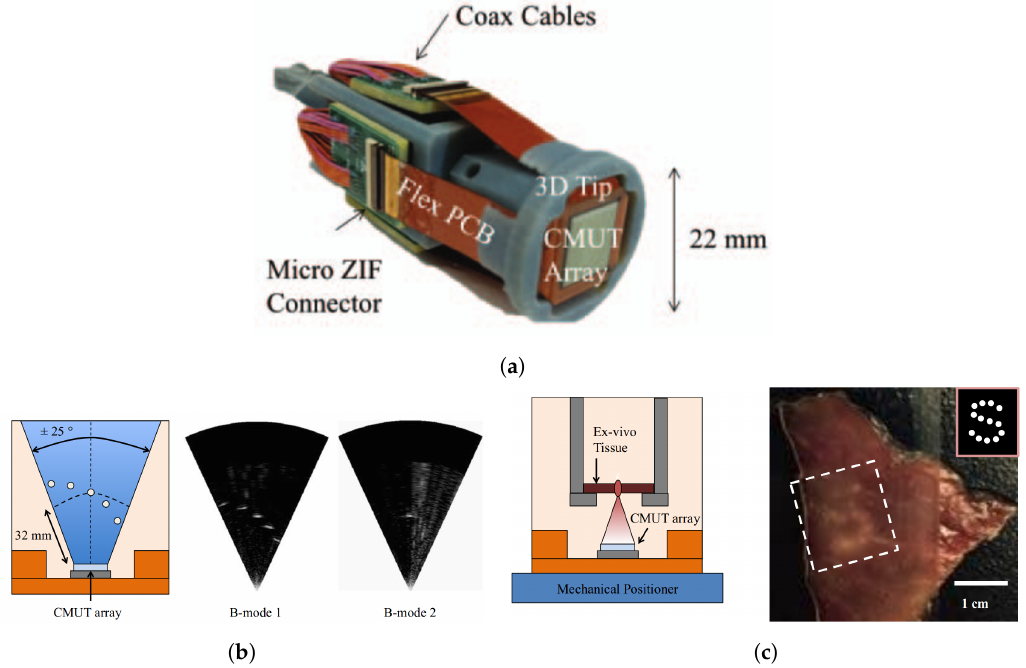
Figure 16. ( a ) The integrated CMUT, IC and flexible printed circuit board (flex PCB) prior to PDMS casting. ( b ) 3D imaging result of a wire phantom. ( c ) HIFU ablation of a piece of ex-vivo tissue. All images from [71]. Reproduced with permission from Jang, J.H. et al., 2015 IEEE International Ultrasonics Symposium